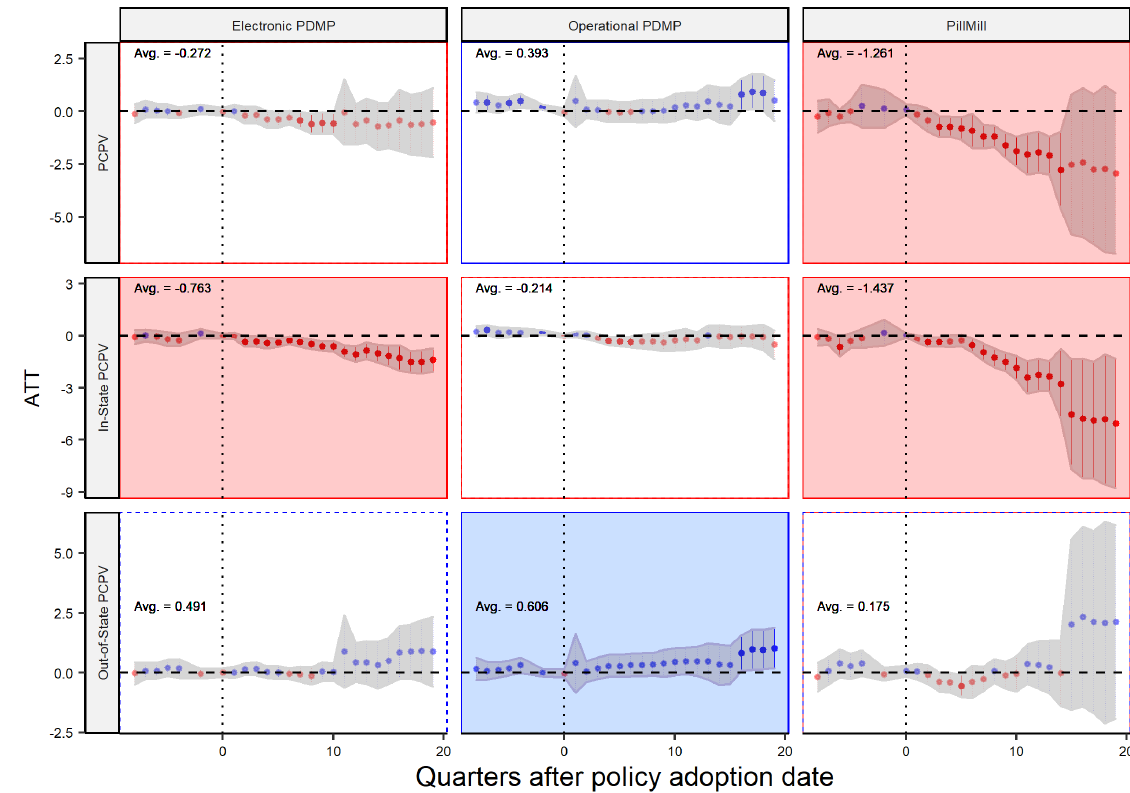
Figure 6. Policy Effect—Player: